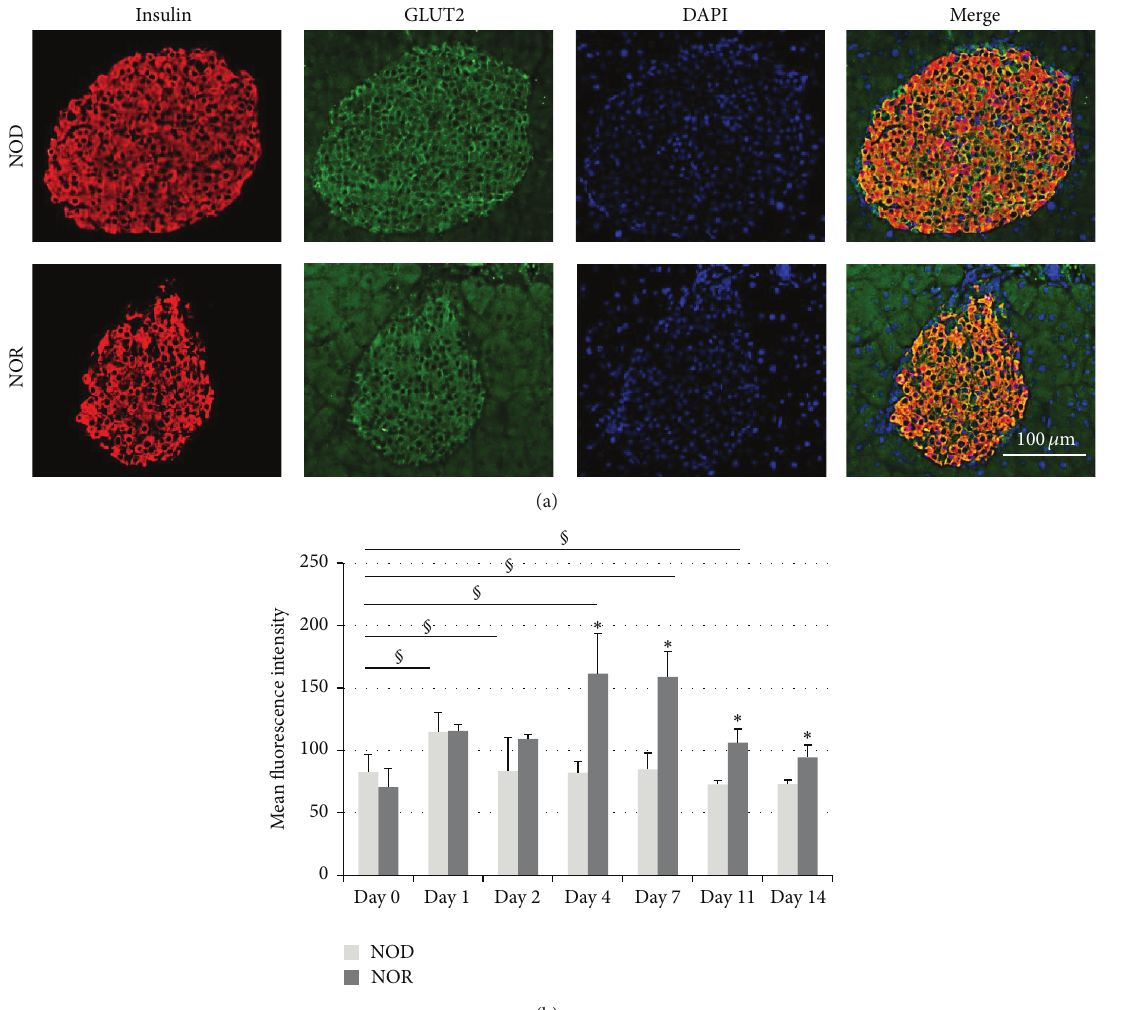
Figure 3: GLUT2 expression levels in the pancreatic beta cells of NOD and NOR mice. (a) Representative images of dual stainings for insulin (red) and GLUT2 expressions (green) in the presence of DAPI counter-staining (blue), before STZ application (day 0). (b) Mean fluorescence intensities for GLUT2 expression in NOD (lighter bars) and NOR islet beta cells (darker bars) on days 0, 1, 2, 4, 7, 11, and 14 of STZ injection. Five to twenty islets per animal were analysed via ImageJ program ( 𝑛 = 3 /group). ∗ 𝑃 < 0.05 , significance between values observed in NOD versus NOR mice; § 𝑃 < 0.05 , significance between values detected in NOR mice before STZ injection and at different time points after treatment (Student’s 𝑡